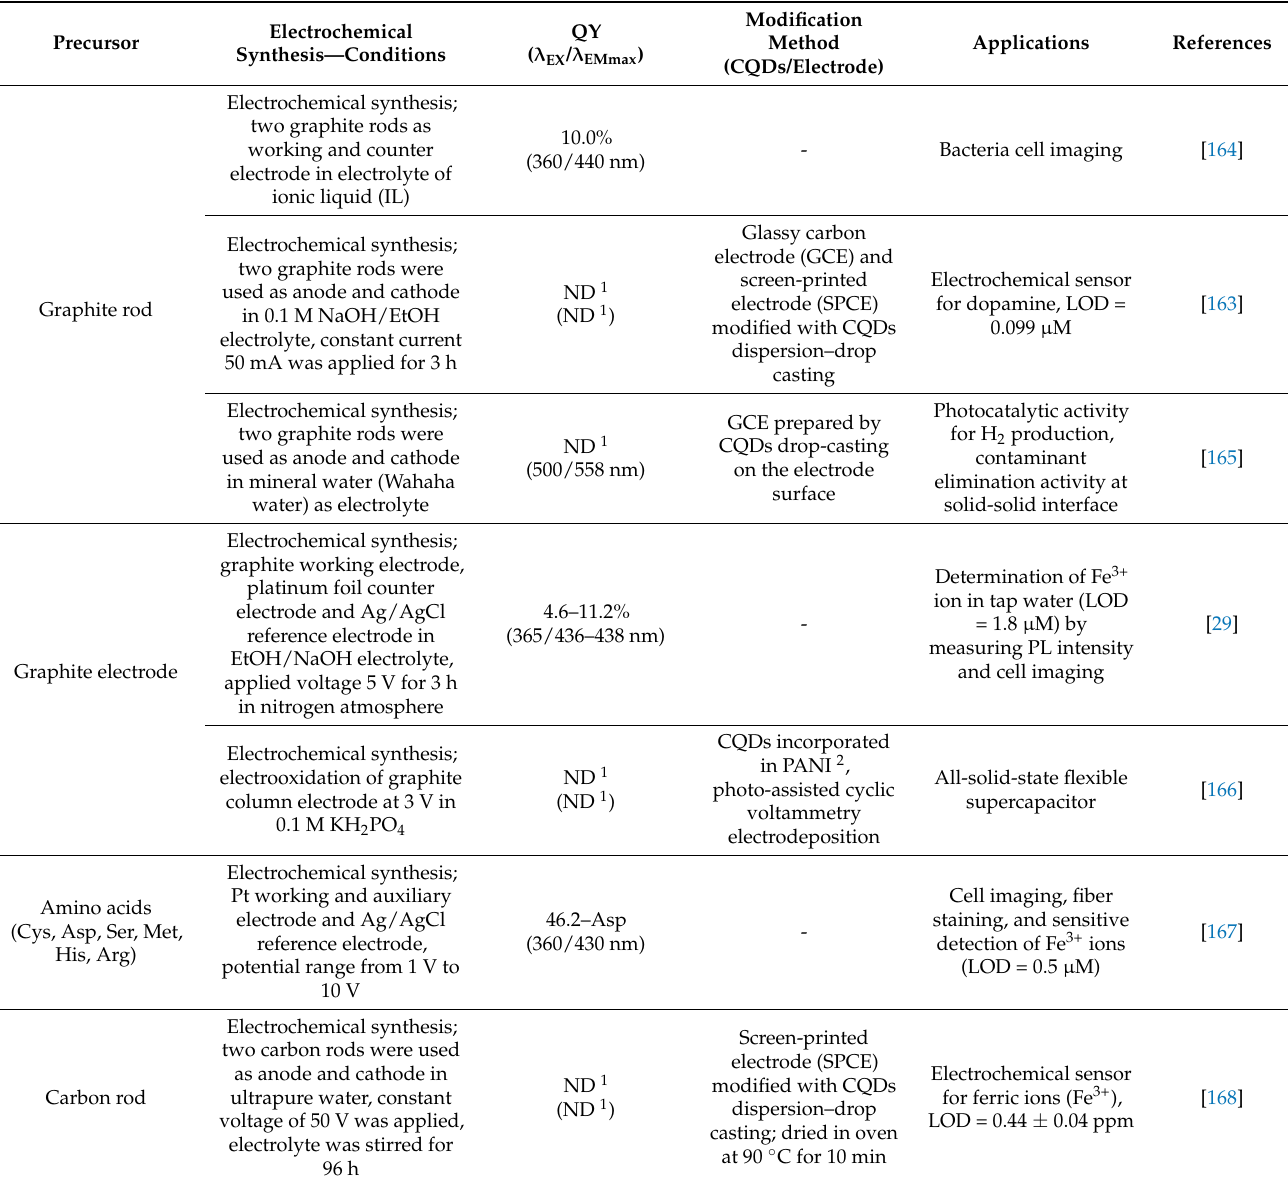
Table 7. Electrochemical preparations of CQDs and their potential